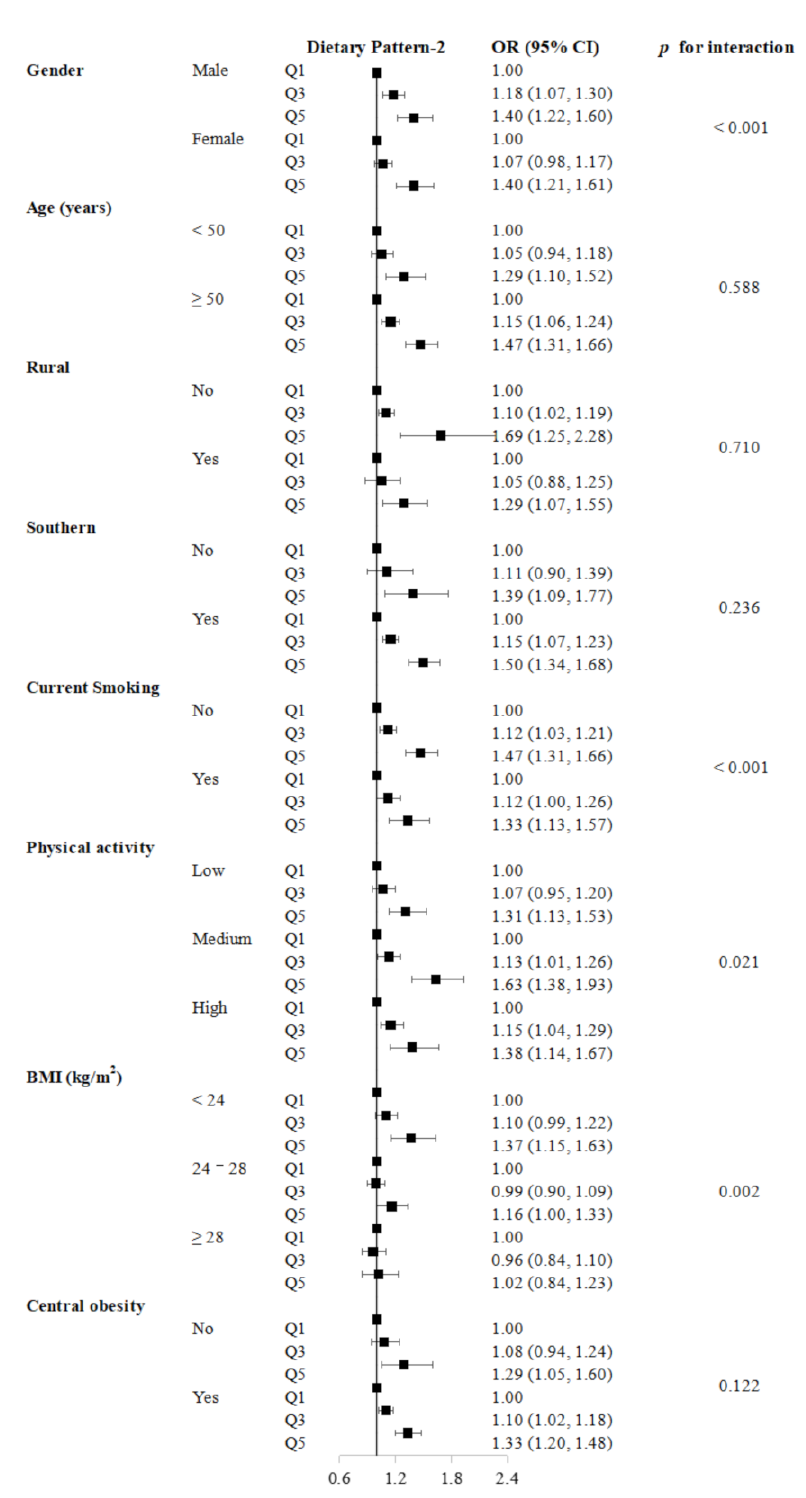
Figure 1. Hazard ratios (HRs) and 95% confidence intervals (CIs) of diabetes incidence according to the quintiles of dietary pattern-2 from stratified analyses from the China Kadoorie Biobank ( n =